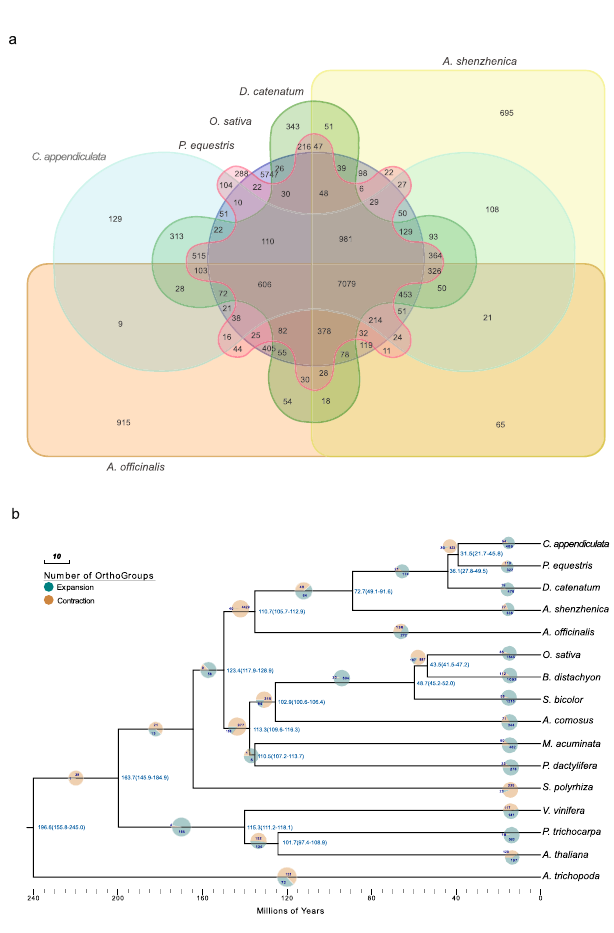
Fig. 2 C. appendiculata genome evolution and the distribution of gene families among six monocot genomes. C. appendiculata genome evolution. a Shared orthologous gene clusters among C. appendiculata , P. equestris , O. sativa , D. catenatum , A. shenzhenica , and A. of fi cinalis . b Phylogenetic tree and number of gene families displaying expansion and contraction of 16 plant